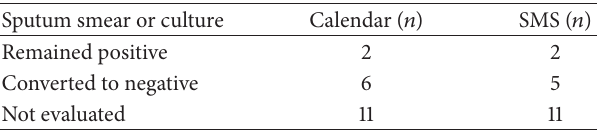
Table 4: Sputum or culture conversion by group after two months of